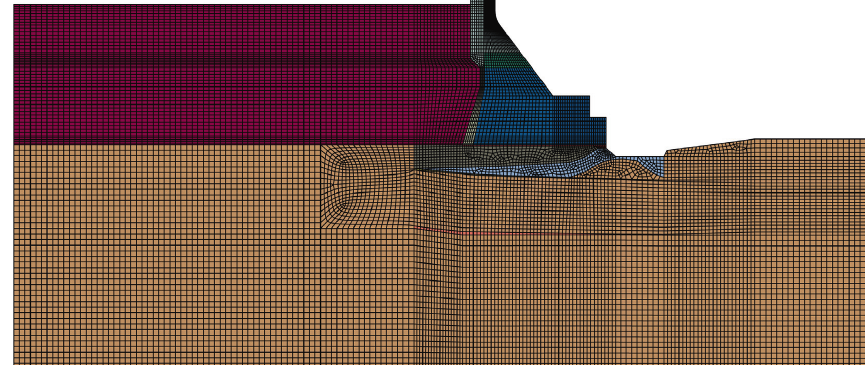
Figure 14: FE mesh of the JinJin’anqiao dam-reservoir-foundation system.